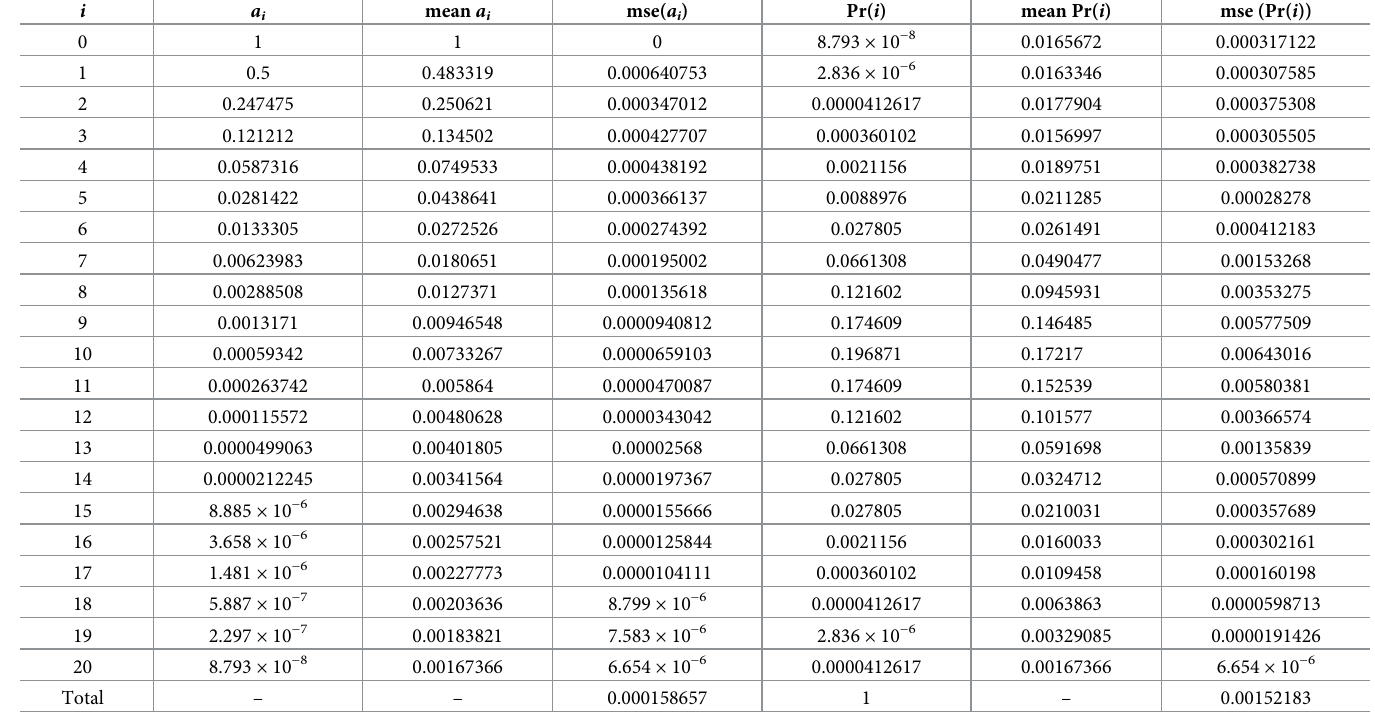
Table 6. Scenario 2. H (100, 50, n ) where n = 5, 10, 20.